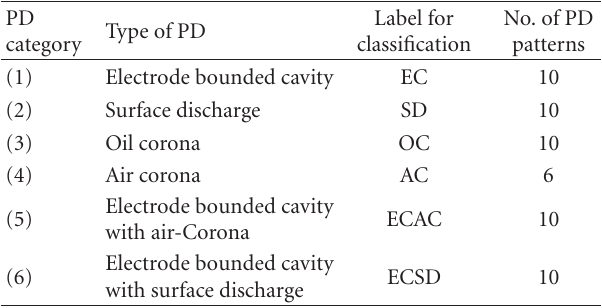
Table 1: Moderate dataset of PD laboratory